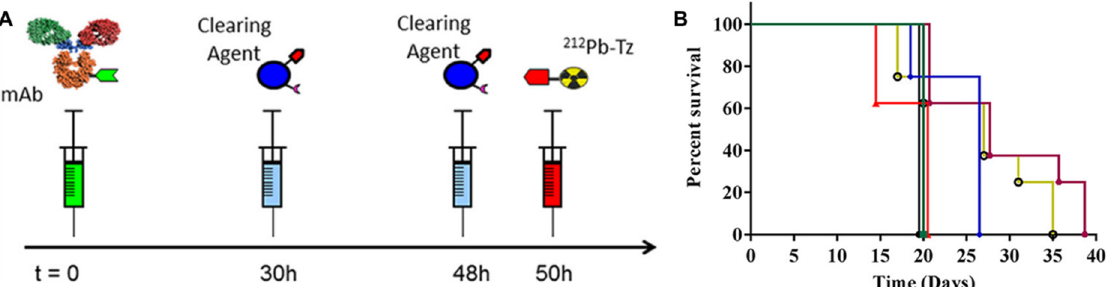
Figure 4. (A ) Schematic representation of the pretargeting protocol used. mAb CC49-TCO, CA ga- lactose-BSA-Tz, and 212 Pb-DOTA-Tz were used. ( B ) Kaplan–Meier survival curves. LS174T tumor- bearing mice were treated with CC49-TCO mAb and treated with CC49-TCO (green ■ ), 2.78 MBq (blue ⧫ ), 4.63 MBq (yellow ○ ), 7.40 MBq (red ▲ ), and 2 × 2.78 MBq (purple ⬣ ) of 212 Pb-DOTA-Tz. Reprinted with permission from Ref.[56]. Copyright 2017, American Chemical Society.